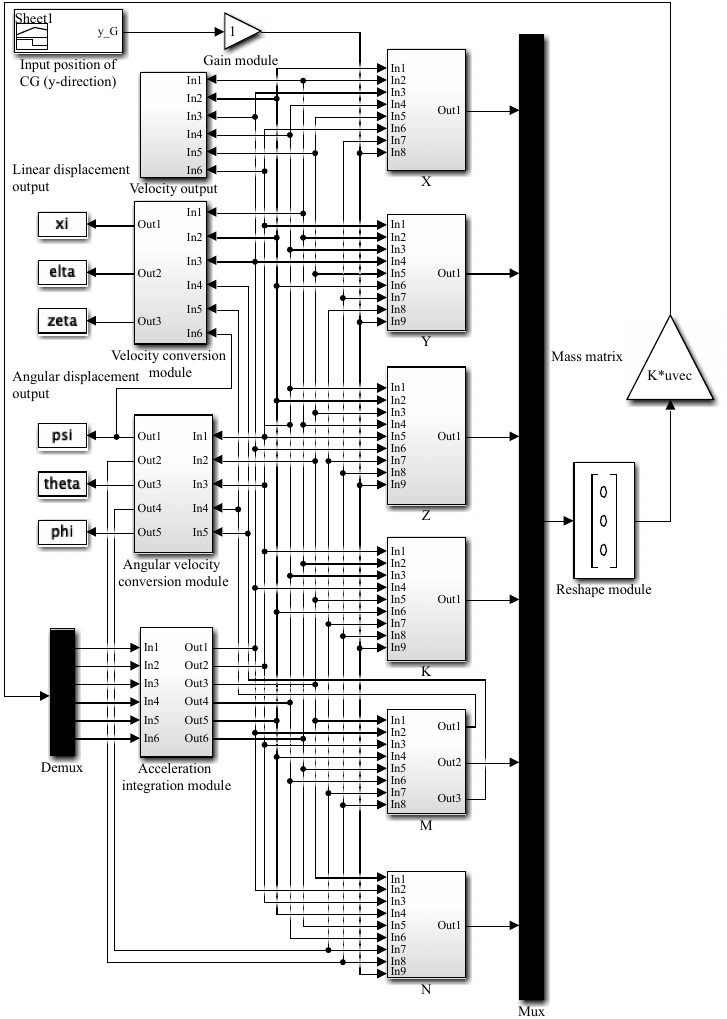
Figure 4. DTUG motion simulator by Matlab and Simulink.